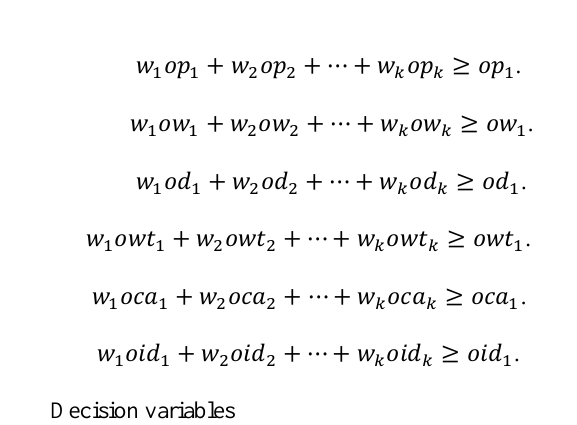
Figure 5. Users phenomenon of dynamic